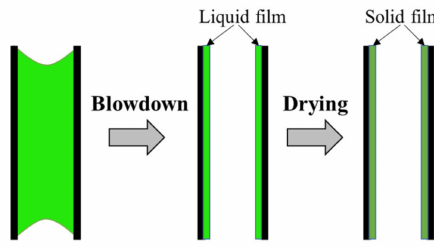
Figure 2. Coating process used by Kolb